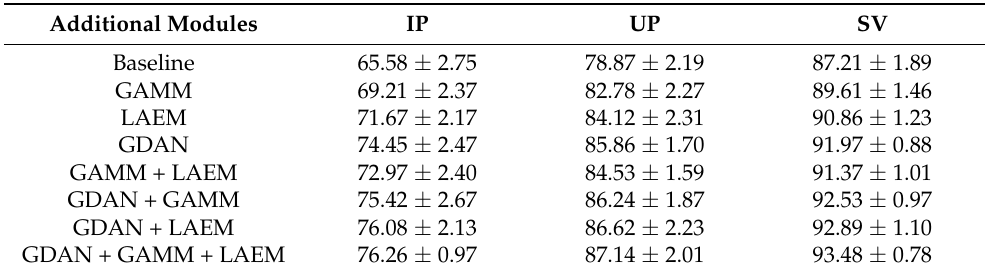
Table 6. OAs obtained by GDAFSL with various proposed modules on three HSI datasets. Additional